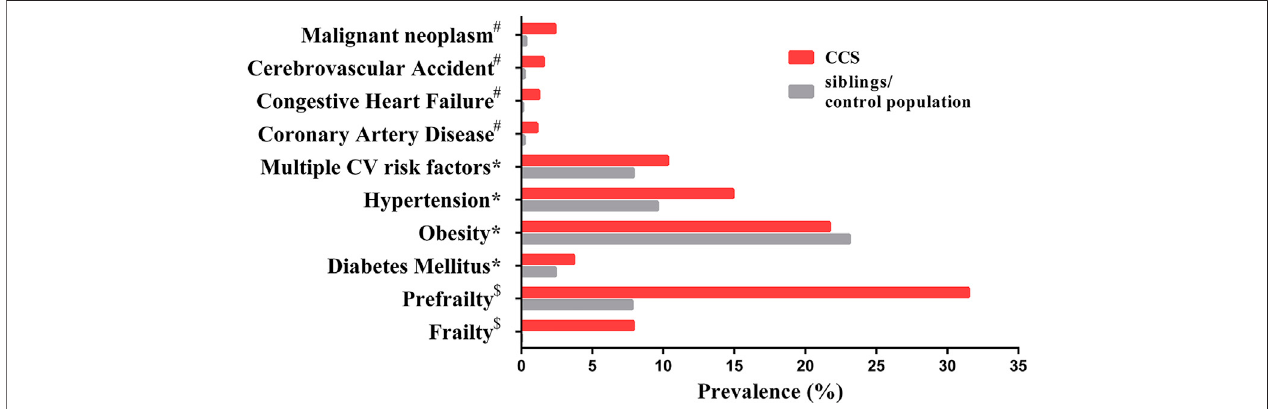
FIGURE1| Theprevalenceofage-associatedcomplicationsinCCSandsiblings/controlpopulation.Datamarked # hasameanageof26.6 years(range18 – 48)for CCS and a mean age of 29.2 years (range 18 – 56) for siblings (Oef fi nger et al., 2006); data marked * has a median age of33.7 years (range 11 – 58) in CCS and a median ageof36 years(range7 – 62)forsiblings(Armstrongetal.,2013);datamarked $ hasameanageof33.6 years(range18 – 50)forCCSandameanageof29 years(range 18 – 50) for the control population (Ness et al., 2013). Malignant neoplasm represents secondary neoplasms for CCS and primary neoplasms for siblings/control population. Abbreviation: CV, cardiovascular.